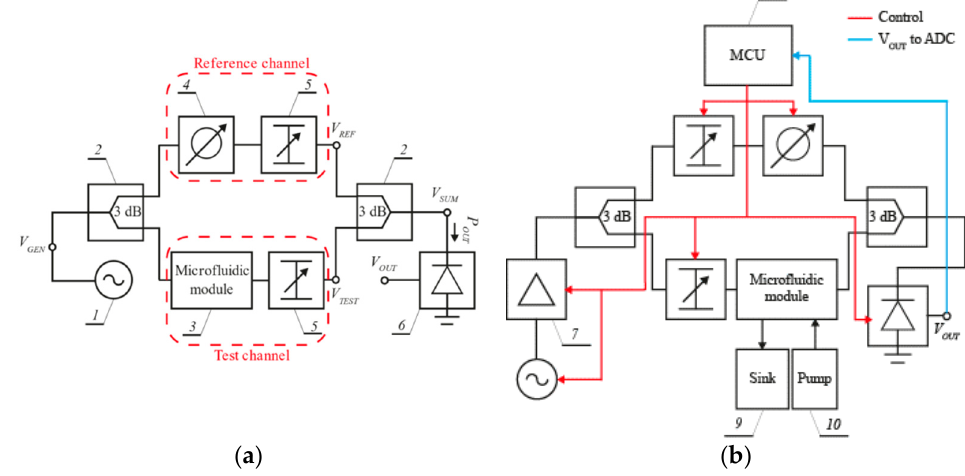
Figure 1. Block schemes of the proposed interferometric system: ( a ) Operating principle; ( b ) vali- dation set-up. 1—VCO, 2—power splitter/combiner, 3—LTCC sensor module with a microfluidic channel, 4—adjustable phase shifter, 5—adjustable attenuator, 6—power detector, 7—power amplifier, 8—MCU controller, 9—sink, 10—pump.